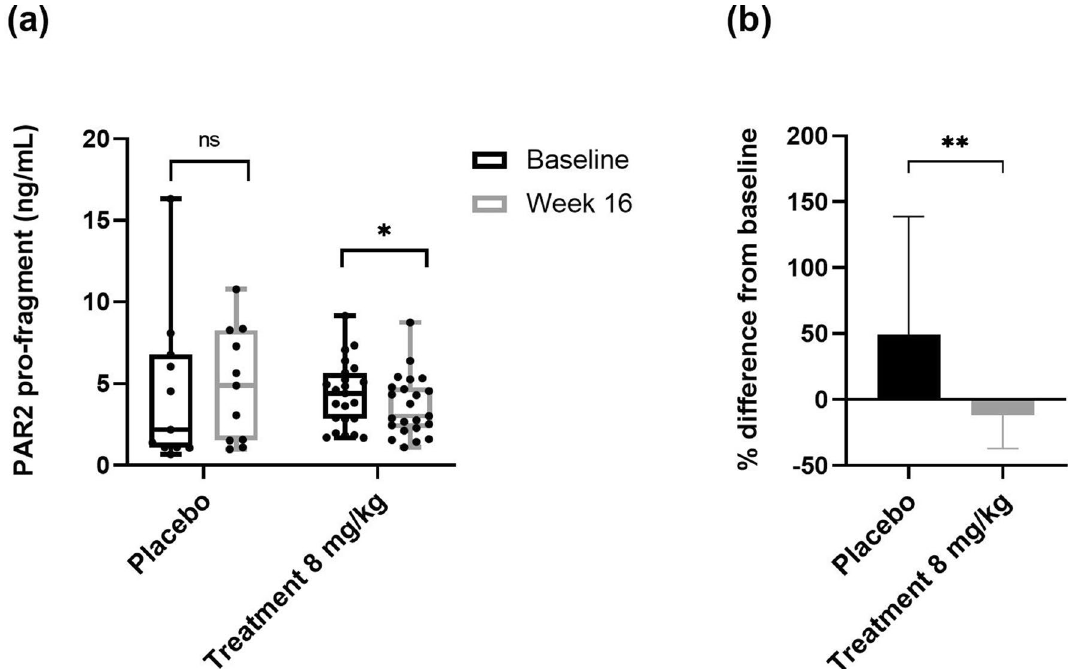
Figure 4. ( a ) PRO-PAR2 levels in placebo and treated patients with tocilizumab at baseline and 16 weeks. PRO-PAR2 levels in the treatment group were compared to the placebo group after 16 weeks. Data are presented as Tukey-Box and whisker plot. Wilcoxon’s paired signed-rank test was used for the comparison. ( b ) Percentage difference from baseline for placebo and treatment group after 16 weeks. Data are presented as mean ± SD. Mann–Whitney test for the percentage change between the placebo and the treatment group was used for comparison. Statistical significance is considered as * P < 0.05, ** P < 0.01 and ns = P >